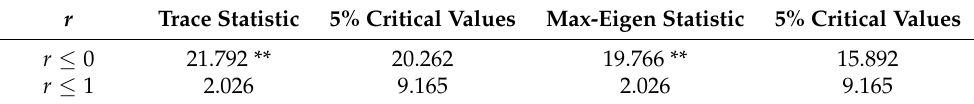
Table 3. Johansen cointegration test.